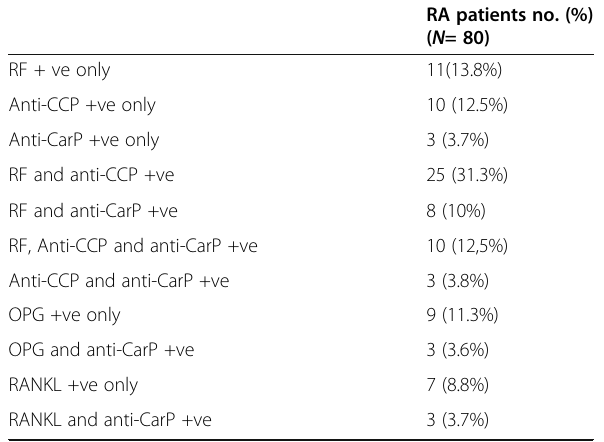
Table 3 Number and percentage of the patients according to laboratory findings positivity: It showed total positive anti-CarP in about 37.5% of the patients